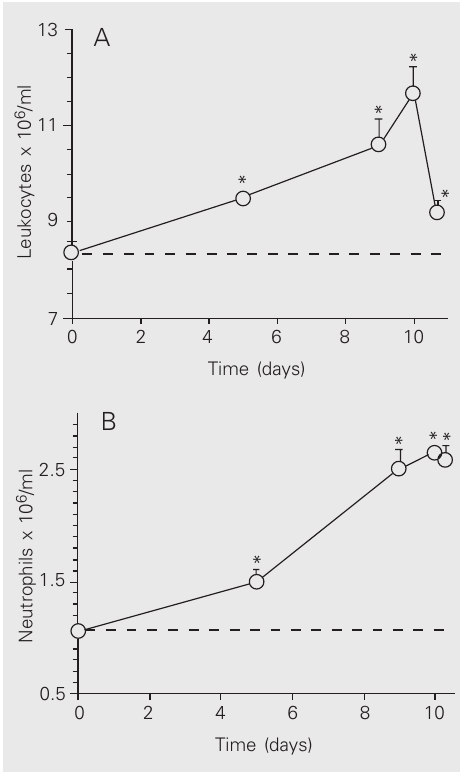
Figure 4. Effect of ethanol inha- lation on total leukocyte (A) and neutrophil (B) counts in peripher- al blood of normal animals. The leukogram was determined be- fore (day 0) and on the 5th, 9th, 10th, and 10th day + 7 h of etha- nol withdrawal. Each point rep- resents the mean ± SEM of the number of leukocytes or neutro- phils x 10 6 /ml for 5-6 rats per group. The dashed line is the horizontal extension of the val- ues obtained on day 0. *P < 0.05 compared to the control period (day 0; ANOVA for repeated measurements, followed by the Bonferroni